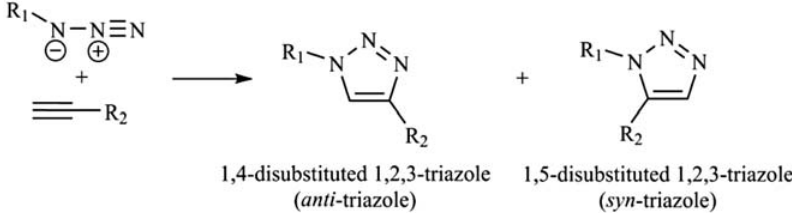
Figure 11. Huisgen’s 1,3-dipolar cycloaddition of azides and alkynes.